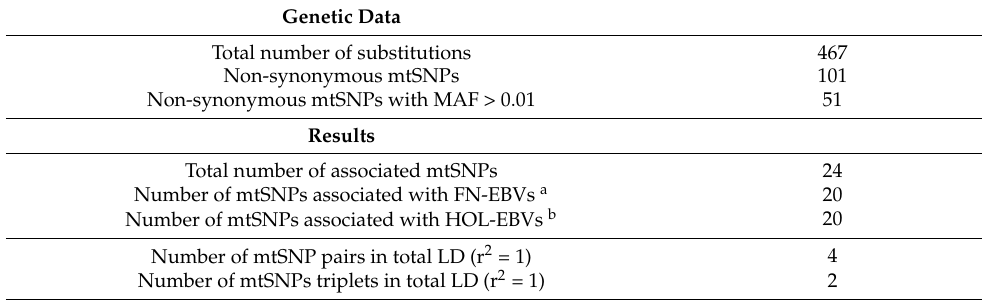
Table 3. Overview of mtSNPs used for mitochondrial association analyses and description of associ- ated